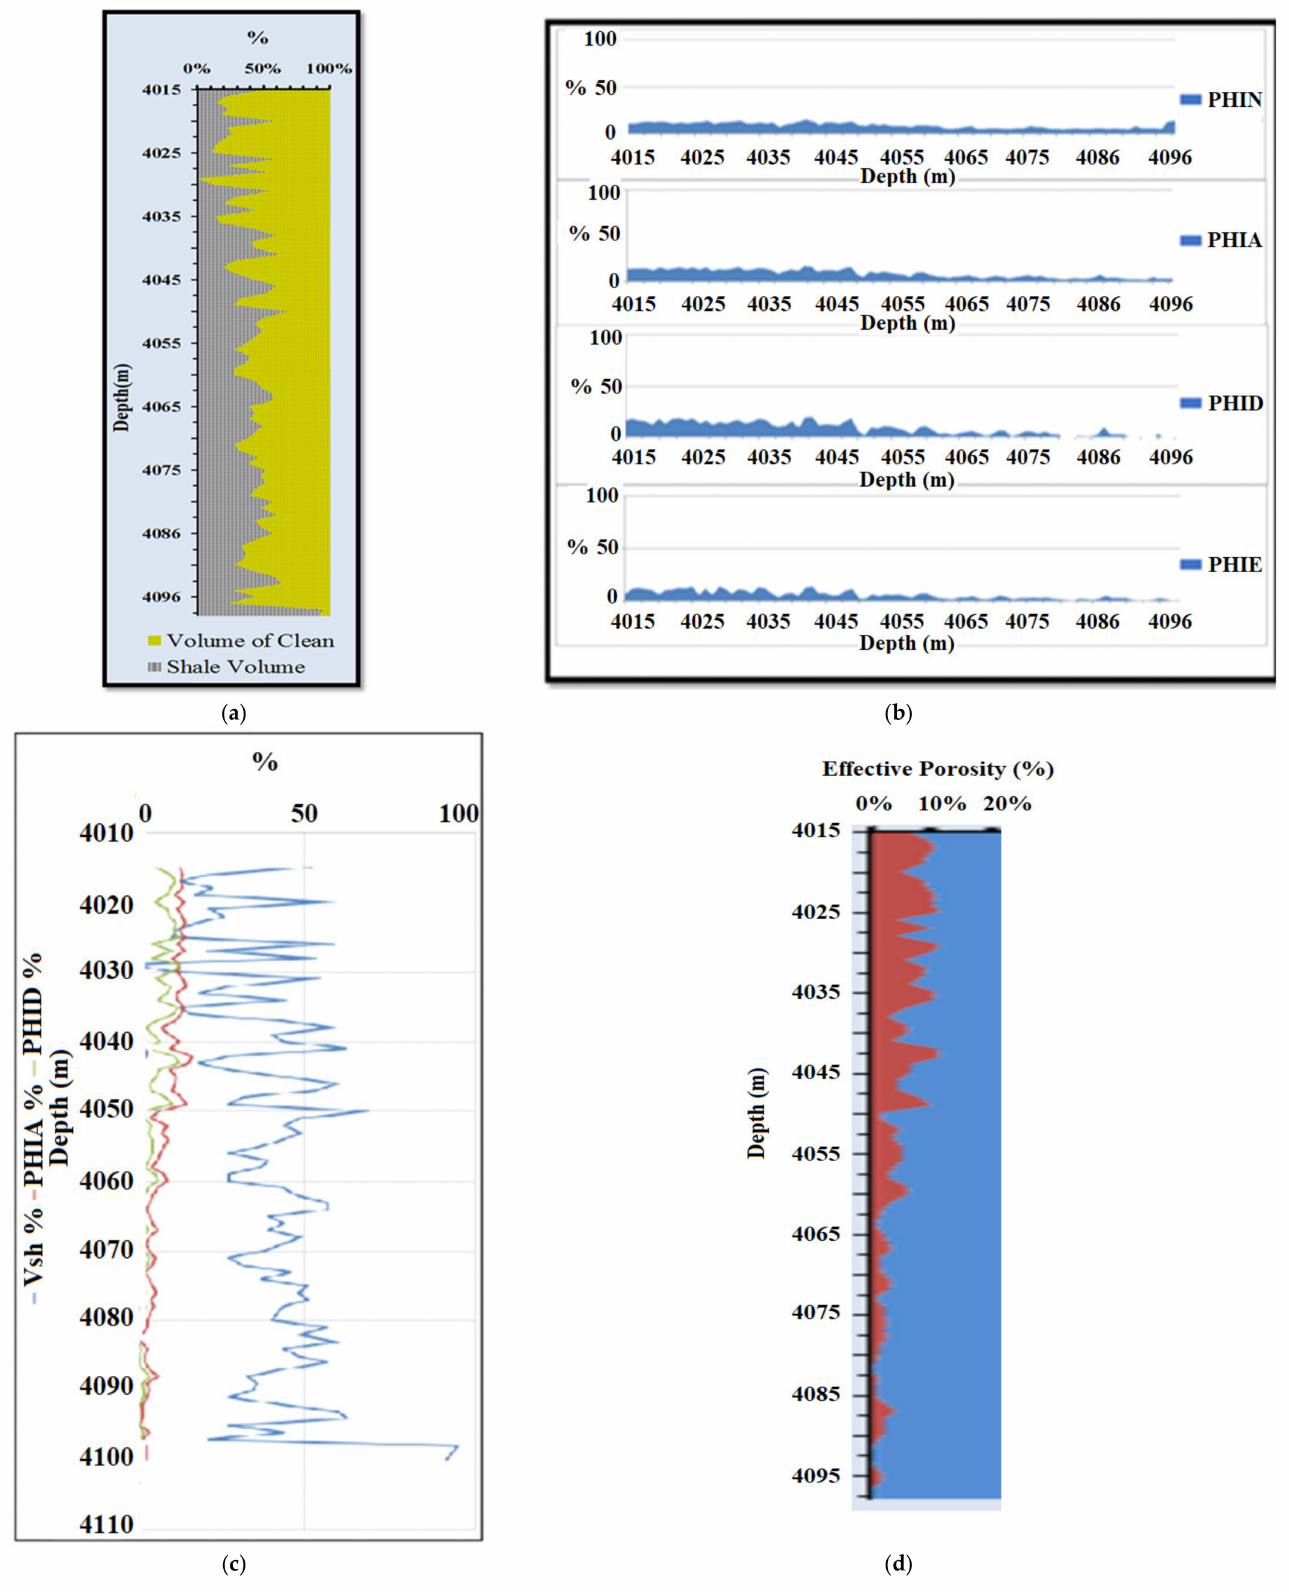
Figure 9. ( a ) Relationship between volume of shale and volume of clean with respect to the depth of zone 2; ( b ) relationship between neutron porosity, average porosity, density porosity, and effective porosity of zone 2; ( c ) relationship between the volume of shale (Vsh), average porosity (PHIA), and average density porosity (PHID) of zone 2; ( d ) variation in effective porosity along the